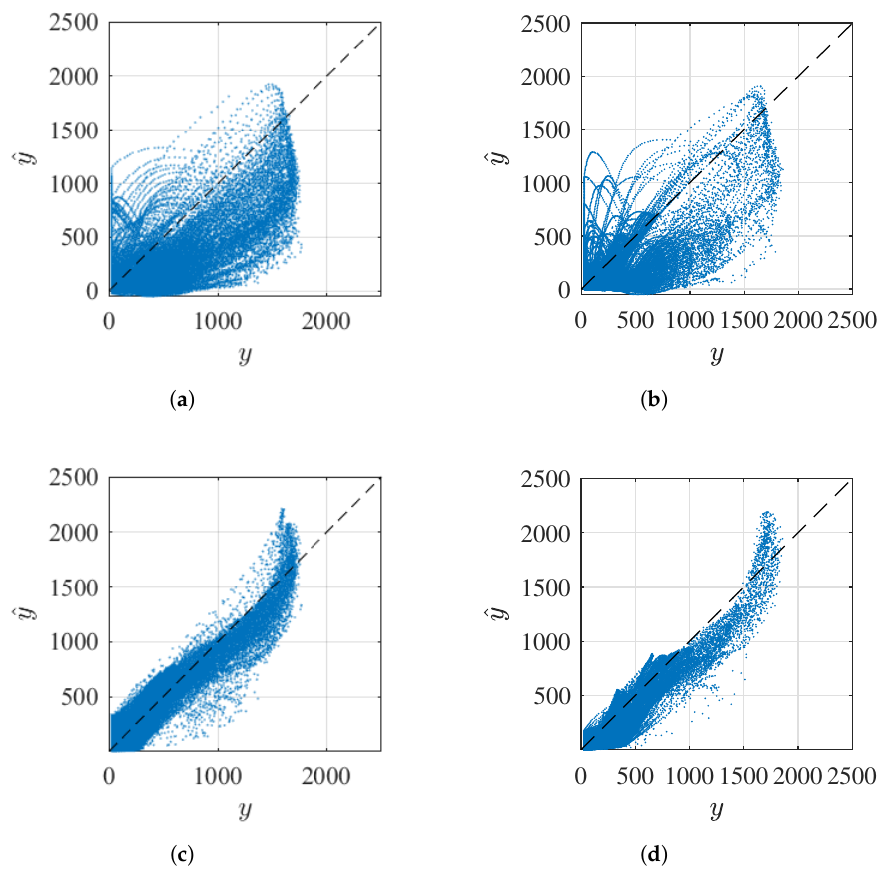
Figure 14. y versus ˆ y plots for multiple tracks experiment. ( a ) ARX model predictions on training data; ( b ) ARX model predictions on validation data; ( c ) OE model predictions on training data; ( d ) OE model predictions on validation data.